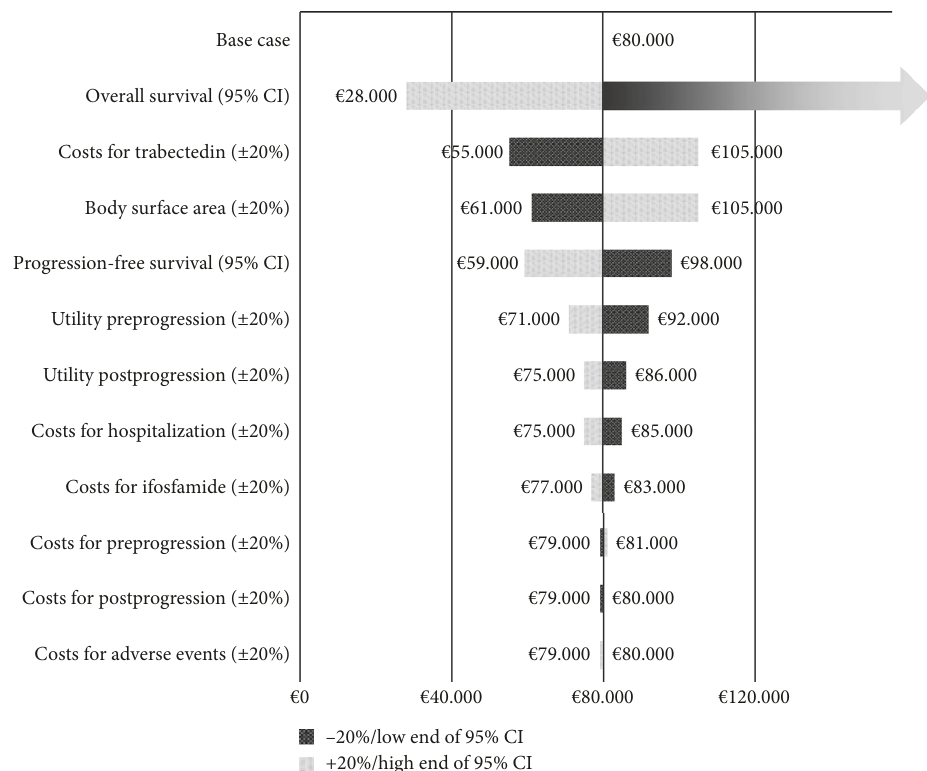
Figure 1: Tornado diagram representing the univariate sensitivity analysis for L-sarcoma, numbers abbreviated to thousands. All variables other than survival were increased (light-shaded bars) or decreased (dark-shaded bars) by 20%. For progression-free survival and overall survival, the 95% confidence interval (95% CI) of the survival difference between trabectedin and ifosfamide was used (low end: light-shaded bars; high end: dark-shaded bars). Note that the bar for the low end of the difference in OS does not stop and no number is given, as ifosfamide dominated trabectedin at that point, with a negative ICER. OS: overall survival; PFS: progression-free